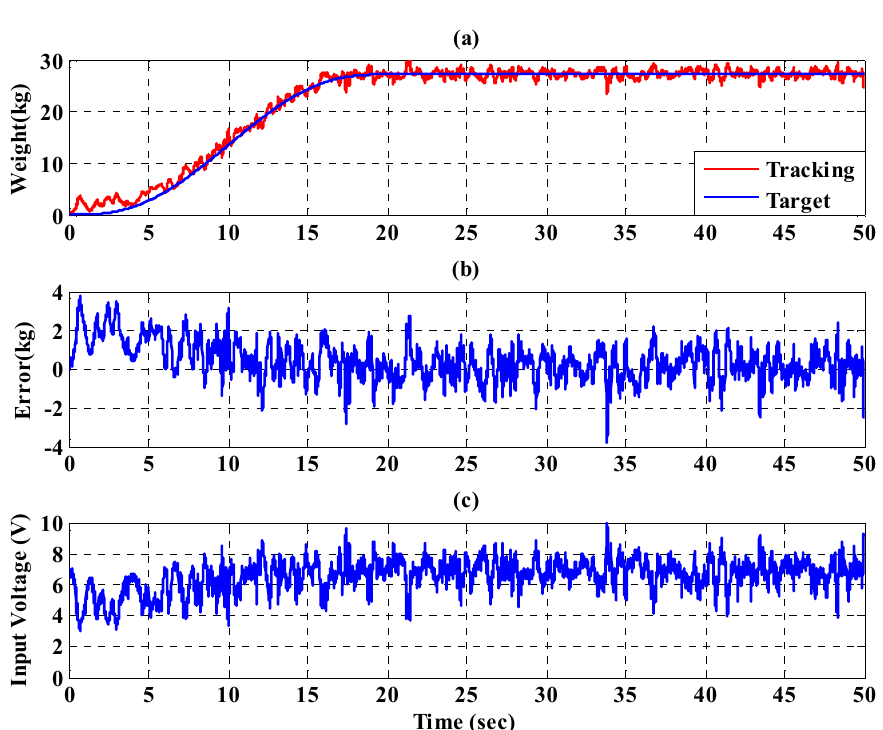
Figure 25 . Experimental results for the PBWSS with a dynamic bodyweight unloading force of 40% (27.2 kg) in 50 s. ( a ) Tracking trajectory; ( b ) tracking error; ( c ) control voltage.